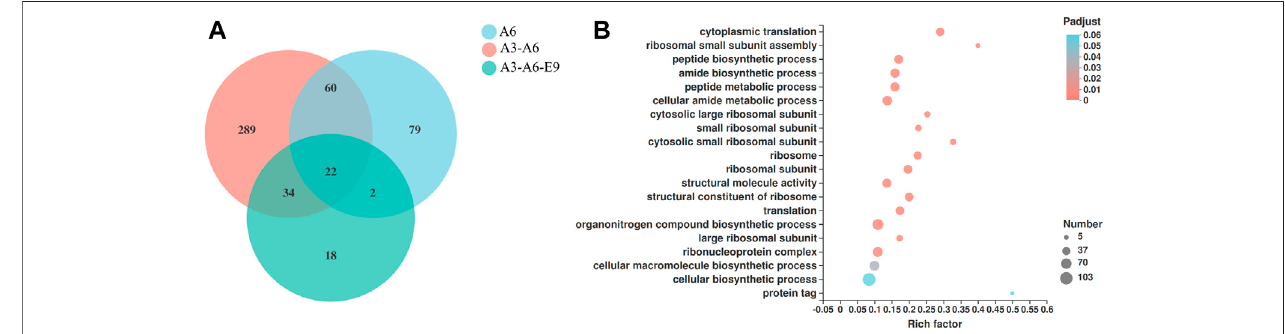
FIGURE 4 | RNA-Seq analysis of the engineered strains with improved functional expression of P450s. (A) Venn diagram showing the number of genes with signi fi cantly different expression levels (fold change ≥ 2 and p -value < 0.05) of the engineered strains (A6, A6-A3, and A6-A3-E9) when compared with the control strain (yJS1256). (B) GO function enrichment bubble plot of genes that show different expression levels in yJS1256- AtGRP7 - AtMSBP1